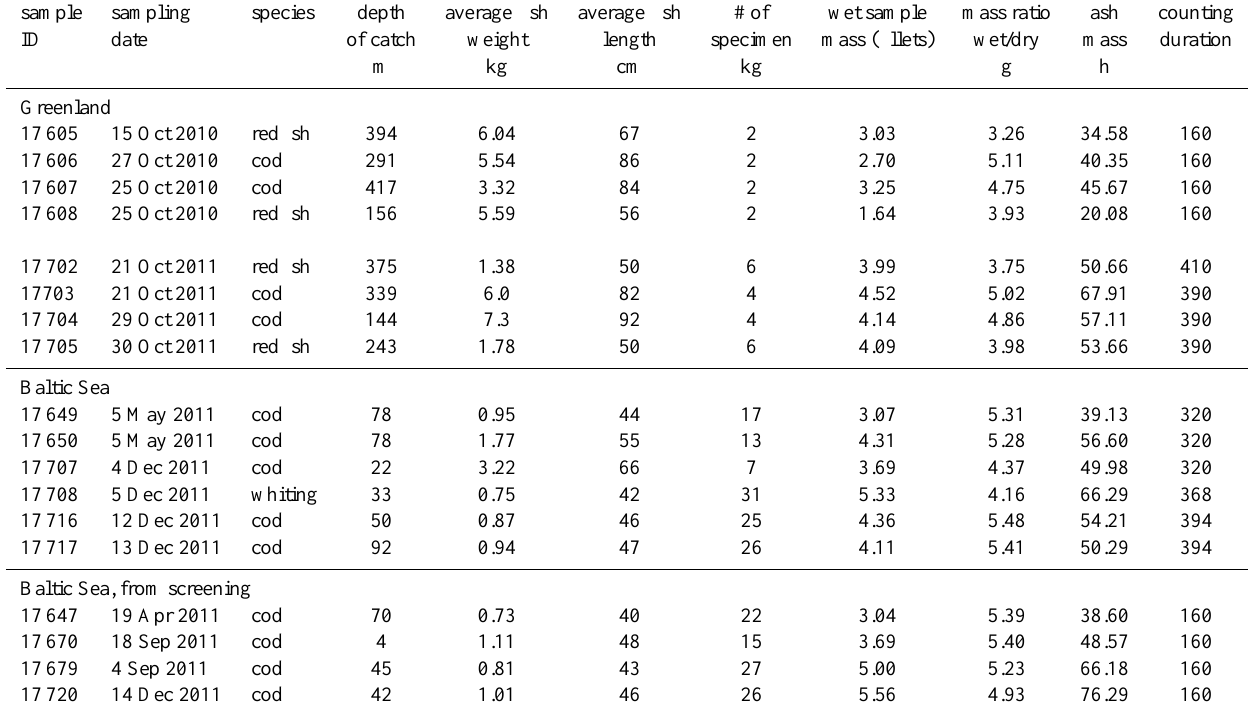
Table 1. Characterization of fish samples (cod: Gadus morhua ; redfish: Sebastes marinus ; whiting: Merlangius merlangius )